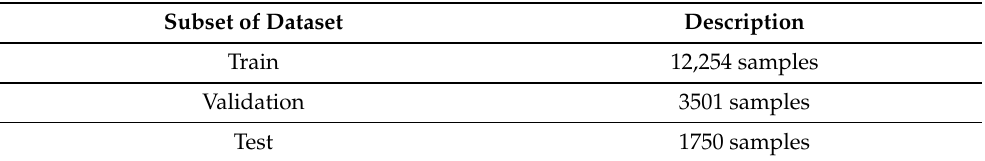
Table 8. Description of each subset of dataset used for mask and goggle detection in a thermo- graphic context.